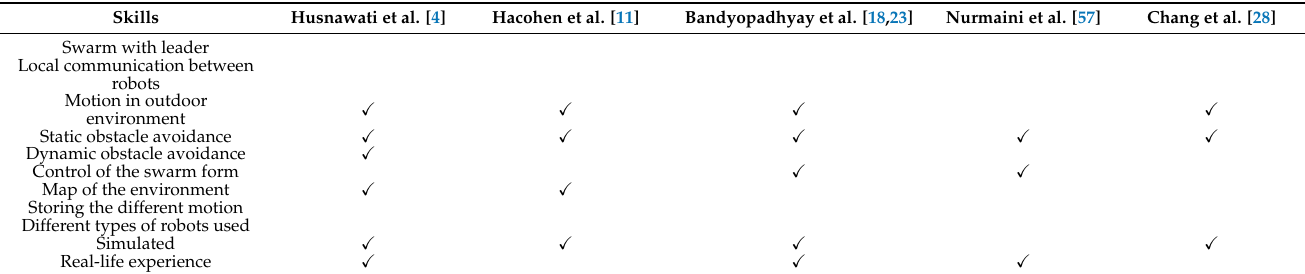
Table 3. Comparison of different probabilistic algorithm for centralised